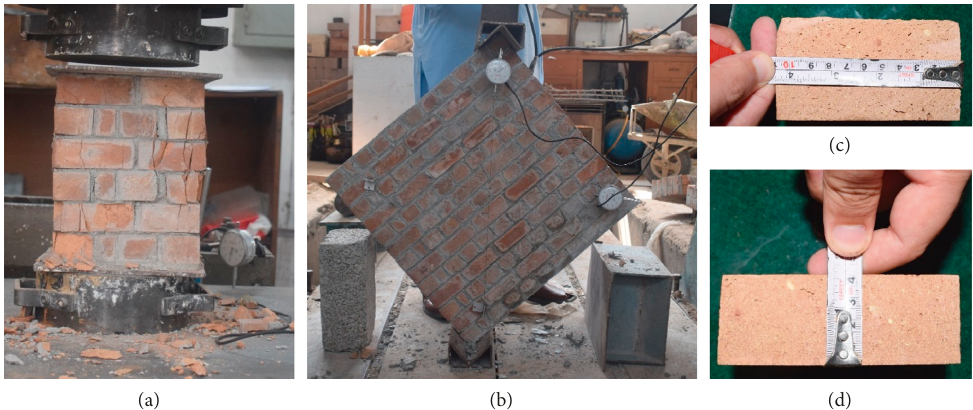
Figure 7: (a) Compressive and (b) diagonal tests of brick prism and (c) length and (d) width of brick specimens.